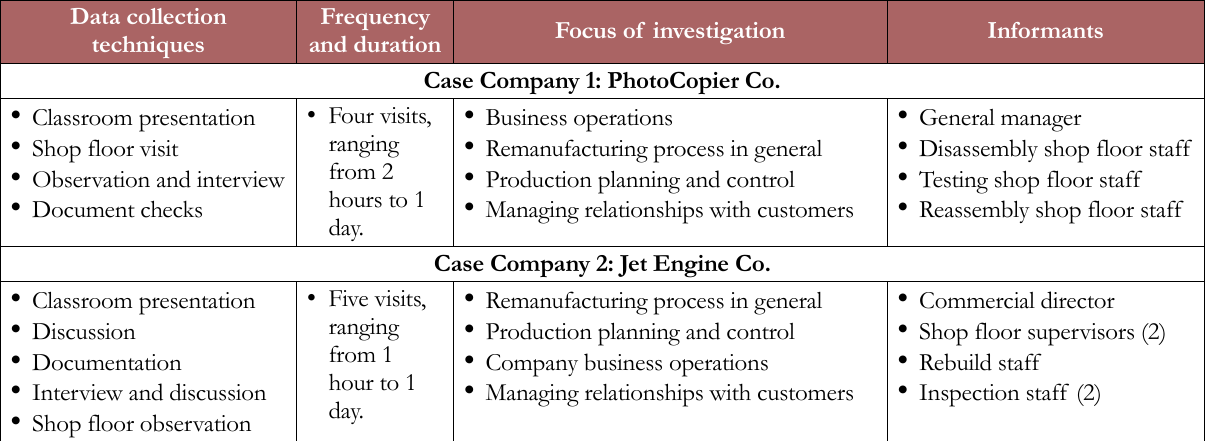
Table 2. The details of data